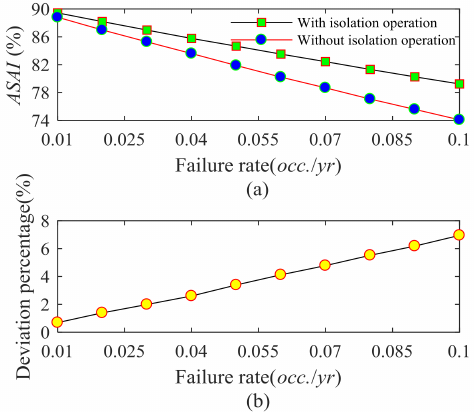
Figure 9. ( a ) ASAI index versus failure rate; ( b ) Deviation percentage of ASAI index between with and without consideration of isolation operation.